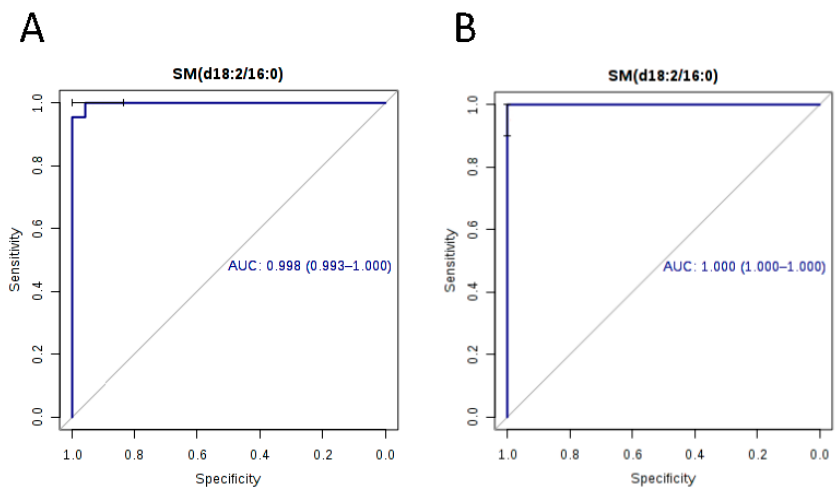
Figure 5. Receiver operating characteristic (ROC) curves for SM(d18:2/16:0) with Area Under the Curves (AUC) with 95% confidence interval, when compared ( A ) between melioidosis and other bacteremia patients; and ( B ) between melioidosis patients and controls without active infection.